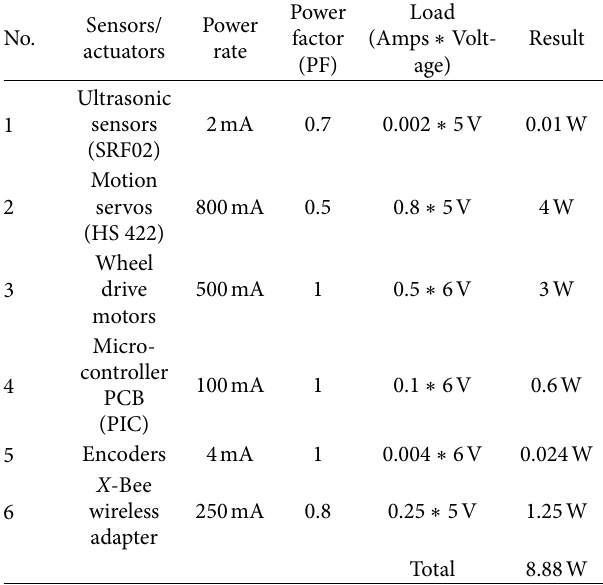
Table 3: Components and loads in robot